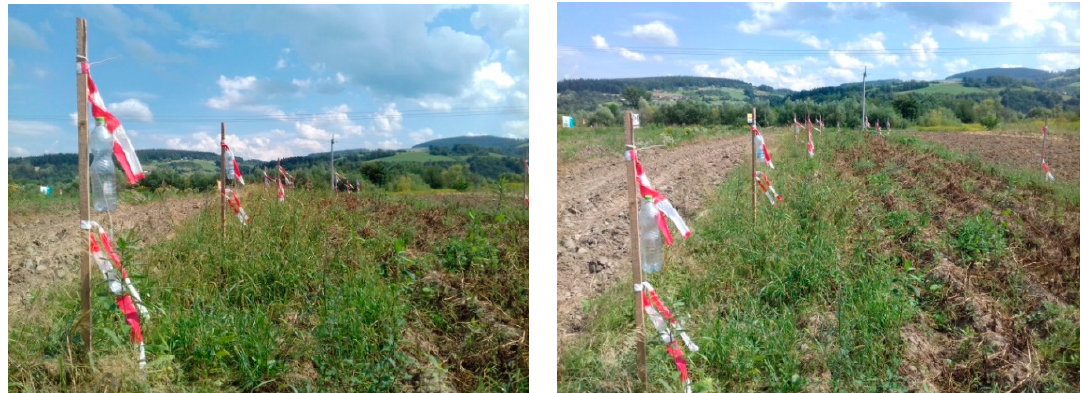
Figure 6. Scarecrows in a vegetable patch. Near Stary S ˛acz (Małopolskie Voivodeship). Source: author.